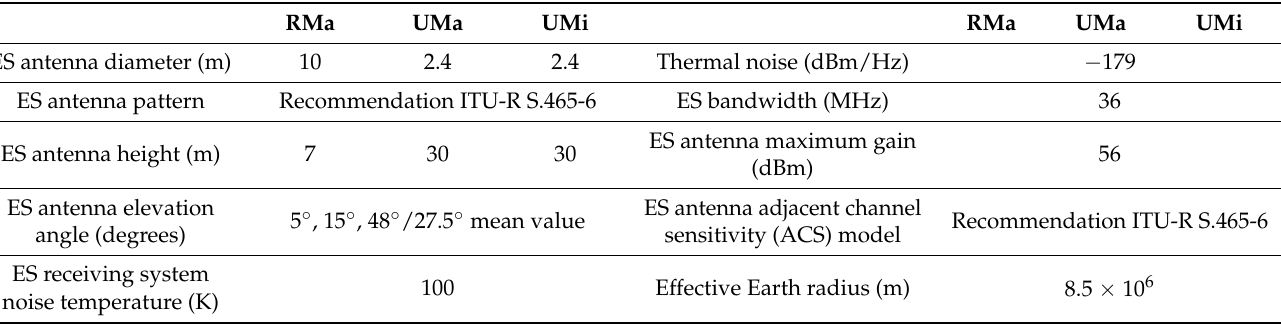
Figure 3. Carrier frequency set to the center frequency in the ( a ) azimuthal and ( b ) elevation planes. Table 2. FSS Earth Station (ES) parameters [13–15].